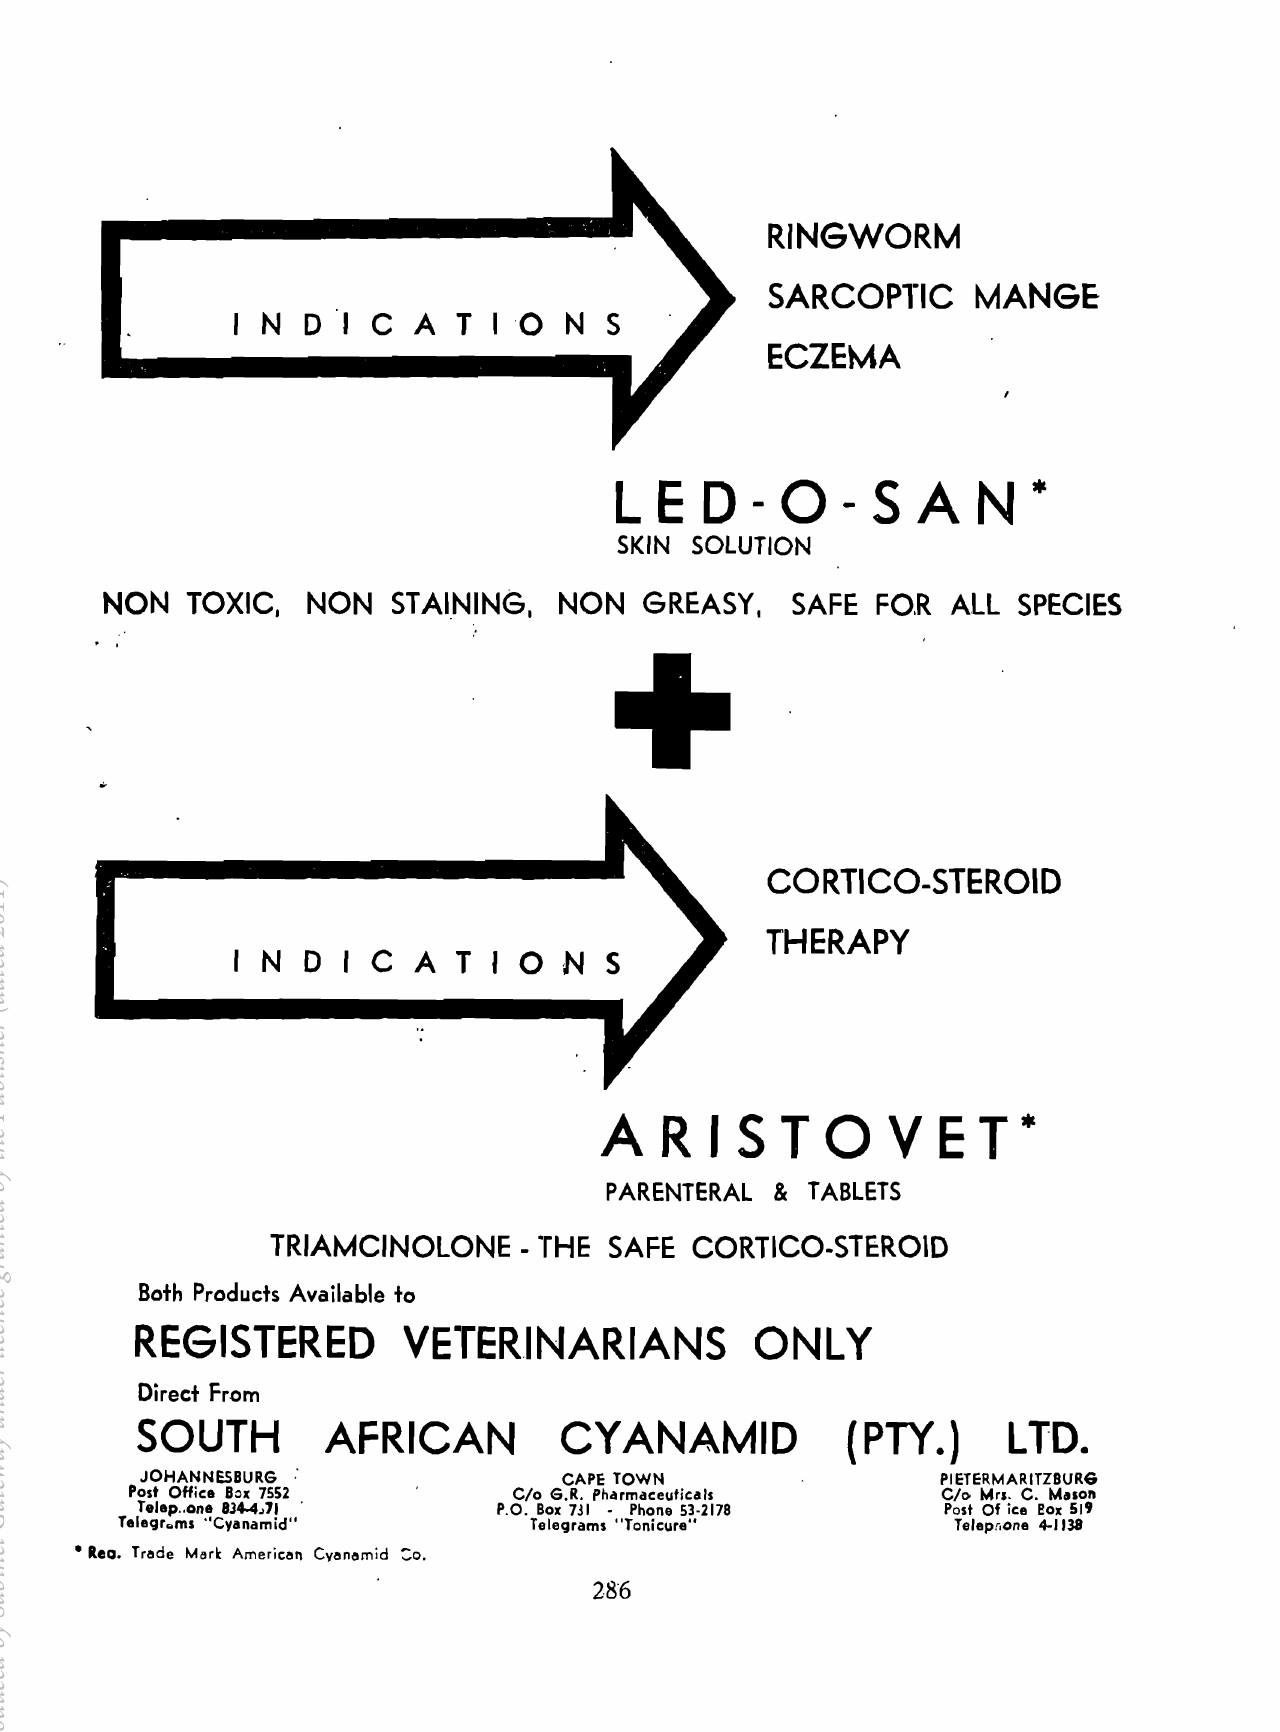
Both Products Available